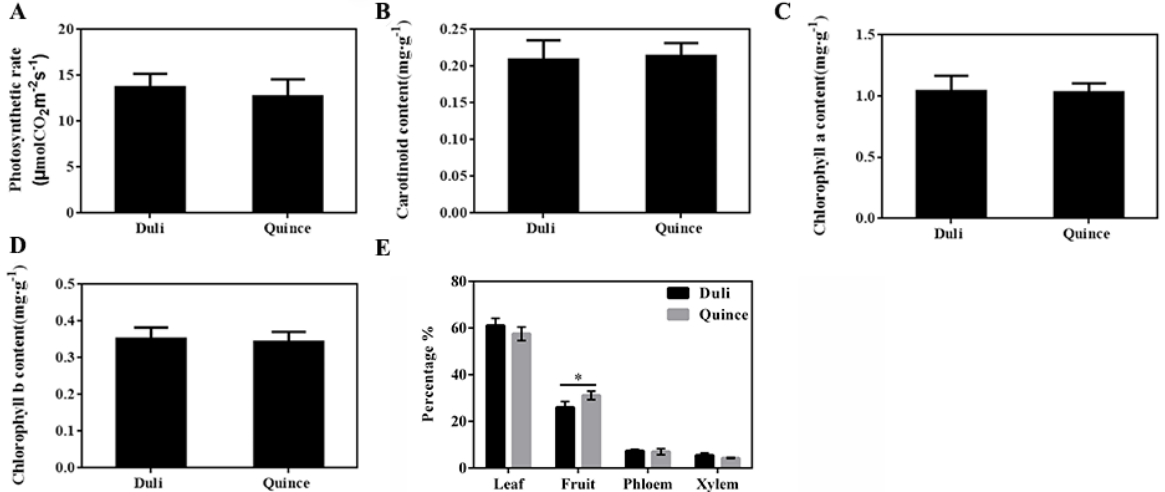
Figure 2. Photosynthetic related indexes and 13 C feeding experiment. ( A ) The leaf photosynthetic rate of ‘Zaosu’ pear grafted on ‘Yunnan’ quince (Z/Q) and ‘Duli’ (Z/D). ( B – D ) The contents of carotenoid, chlorophyll a, and chlorophyll b. ( E ) The percentage of 13 C in each organization. The data represent the mean values ± SDs. Asterisks indicate significant differences as determined by Student’s t tests (* p <